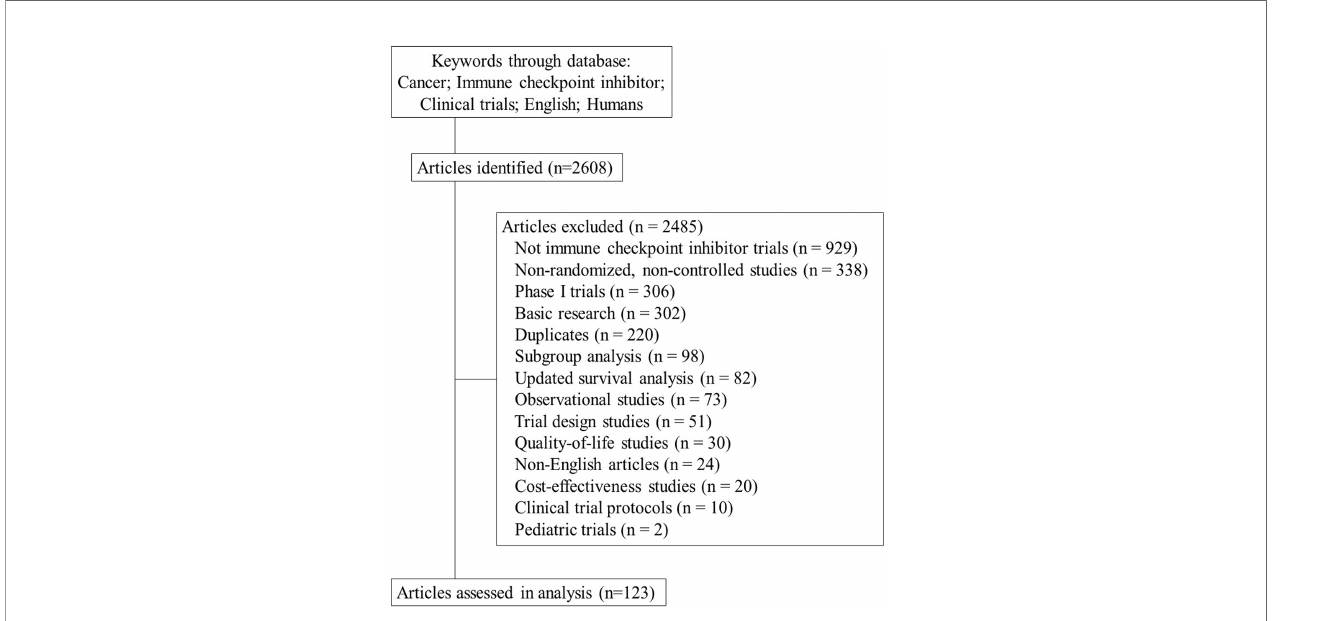
FIGURE 1 | Flowchart of screening of publications on immuno-oncology clinical trial included in the systematic